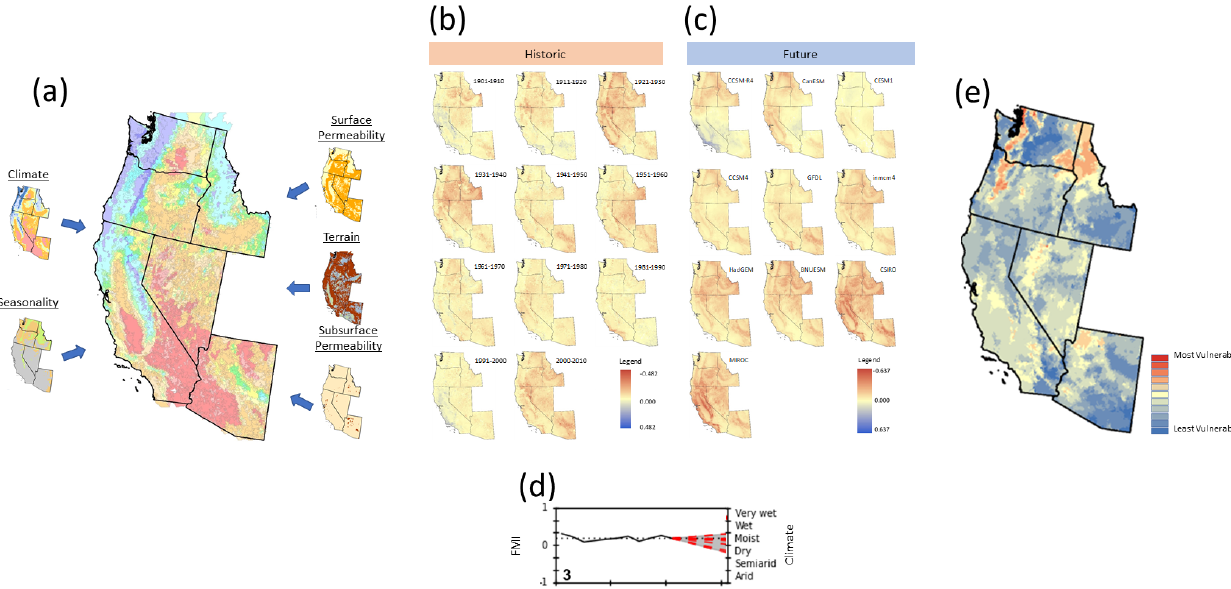
Figure 2. Mapping of hydrologic vulnerability. (a) A hydrologic landscape map is developed for six western states using 1971–2000 normals for climate (Feddema Moisture Index; FMI) and seasonality, along with surface permeability, terrain, and subsurface permeability geophys- ical data. (b) Historical decadal analysis is run from 1901 through 2010 for each of seven metrics: monthly temperature, precipitation, potential evapotranspiration, surplus water, snow water equivalent, FMI (shown), and seasonality. (c) Future predicted behavior is estimated for each of the seven metrics, based on 10 climate model projections (FMI shown). (d) Vulnerability is then defined as the number of climate projections that lie outside of the historical 2 standard deviation threshold (example for FMI from Napa–Sonoma shown). (e) Vulnerability values are then mapped for each metric across the six-state study area (FMI